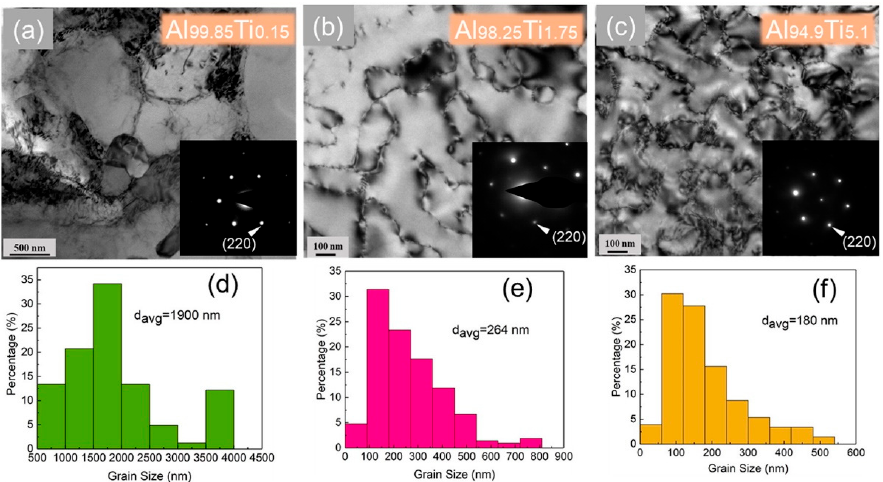
Figure 23. ( a – c ) Plan-view TEM micrographs and (insets) selected area diffraction (SAD) patterns of Al–Ti alloy films with various compositions showing the formation of (111) highly textured films. ( d – f ) Statistics of grain size distributions show substantial grain refinement, from 1900 to 180 nm with increasing Ti concentrations